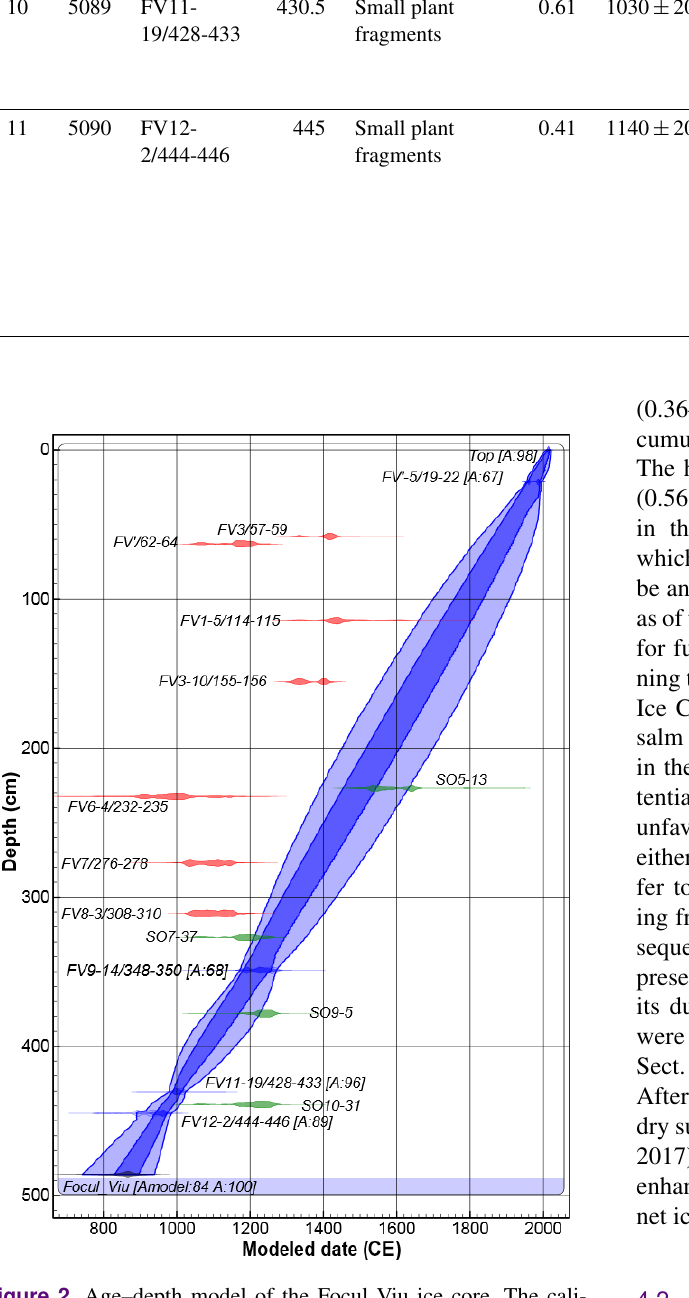
Figure 2. Age–depth model of the Focul Viu ice core. The cali- brated age range of samples used in the model is indicated in blue; rejected samples are indicated in red. Samples in green are from the ice core drilled in 2004 (Maggi et al., 2008). Dark and light blue shading indicates the 95% and 68% confidence ranges of the model,